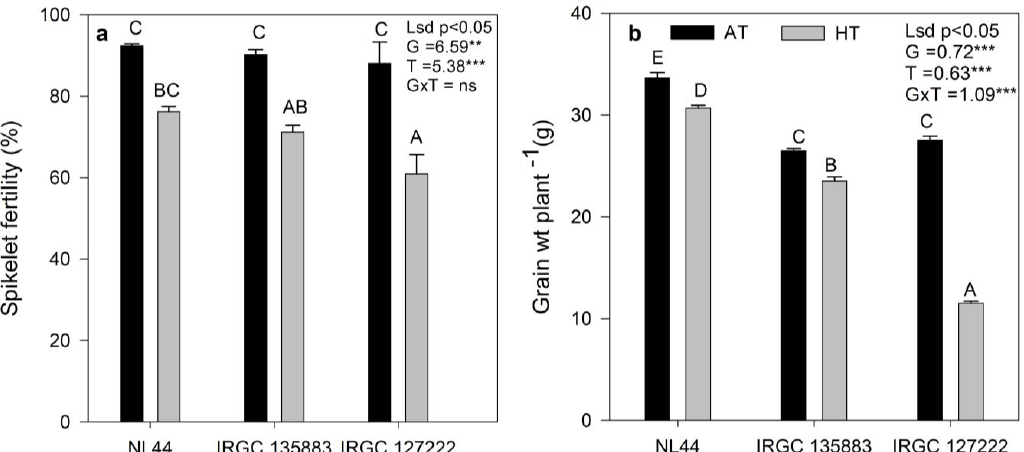
Figure 7. The effect of ambient-temperature (AT) and high-temperature (HT) exposure on ( a ) spikelet fertility, ( b ) grain weight per plant of contrasting rice accessions at the reproductive stage. Means of three replicates are indicated by the vertical columns in the figure. Error bars indicate the ± SEM. The least significant difference test was used to determine significance. Means with the different letter are significantly different at level: ** p < 0.01, *** p < 0.001, ns non-significant.